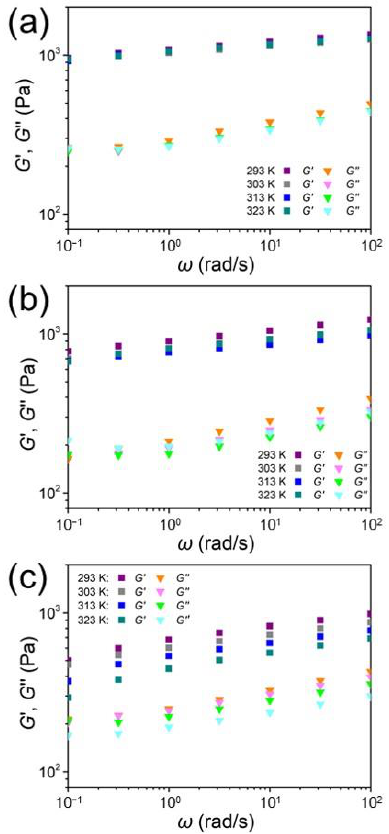
Figure 4. Storage (square) and loss (triangle) moduli versus frequency at different temperatures for the polymer gels ( a ) G-G , ( b ) G-H , and ( c ) G-HG .